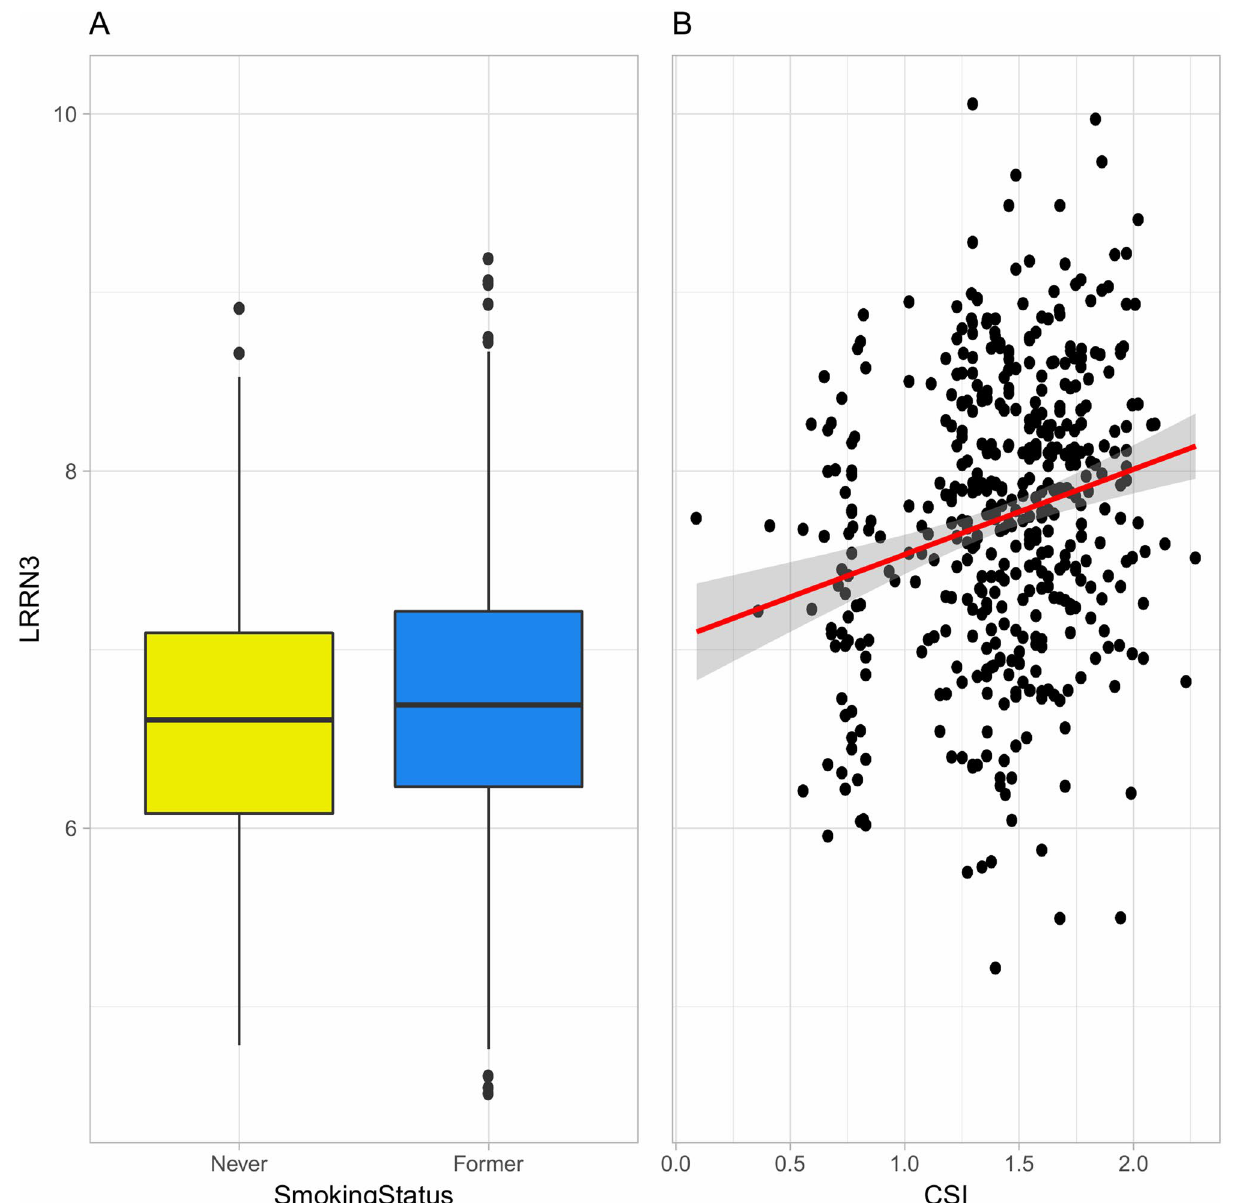
Figure 3. Distributions of expression values for the top-ranked gene ( LRRN3 ) ( A ) among never (yellow) and former (blue) smokers and ( B ) among current smokers according to comprehensive smoking index (CSI) scores. In figure ( A ), boxes extend from the 25th to the 75th percentile, horizontal bars represent the median, whiskers extend 1.5 times the length of the interquartile range above and below the 75th and 25th percentiles, respectively, and outliers are represented as points. In figure ( B ), the red line represents the linear regression fit and the shaded grey area its standard